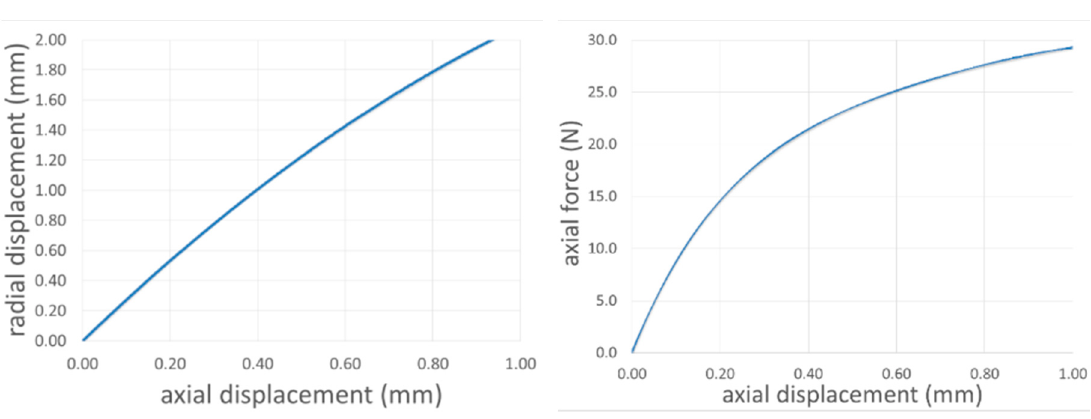
10 of 24 Figure 7. Finite element model of the cell body: global view and main dimensions ( left ); mid-span cross-section ( right ) [30]. FEM (Finite Element Method) analyses provided a detailed description of the evolution of the